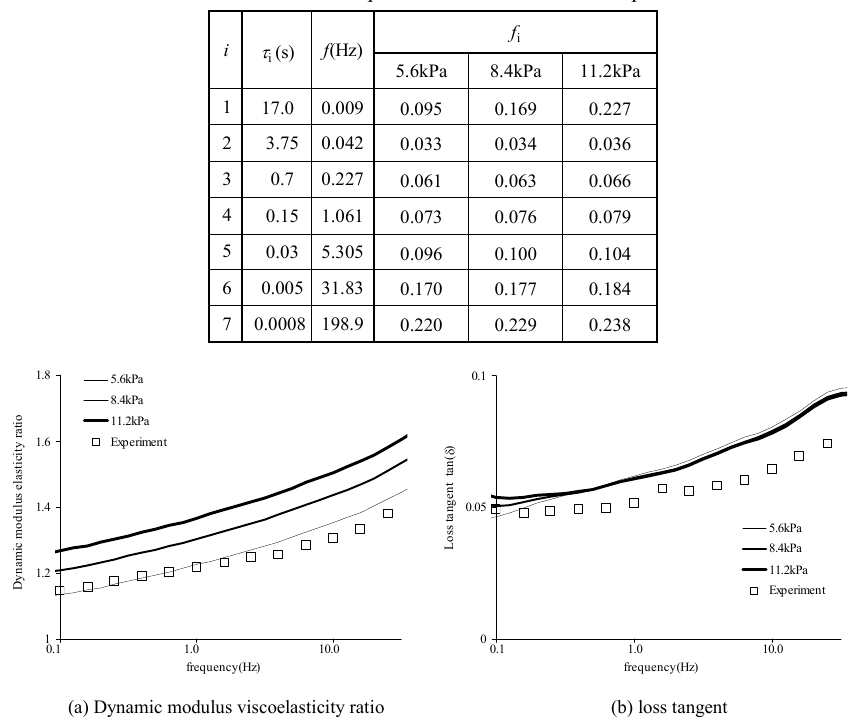
Fig. 9 Change in viscoelastic properties of silicone tube